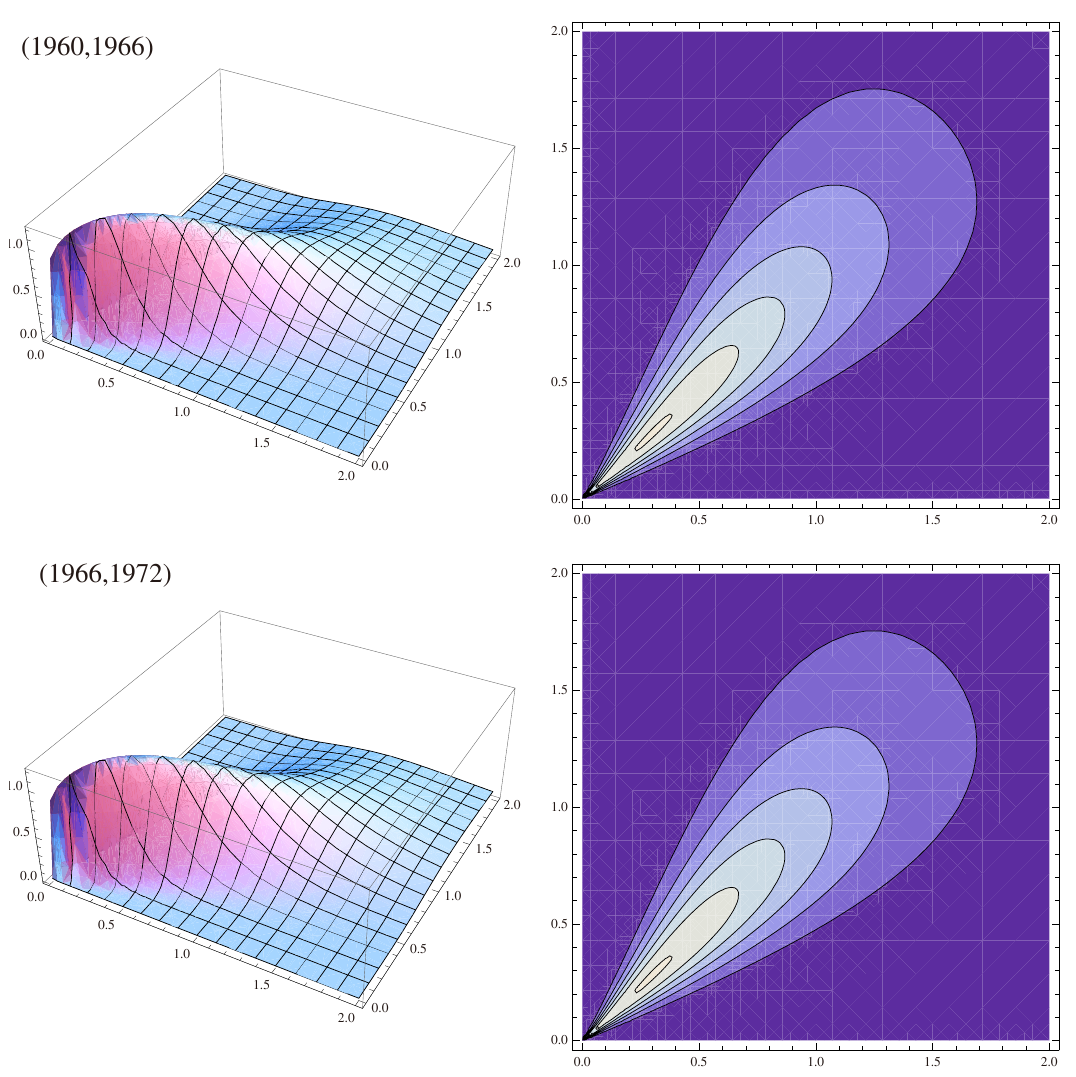
Figure 2. Joint pdf and contour plots of the bivariate income Singh–Maddala distribution for the years: ( 1960,1966 ) ( top ); and ( 1966,1972 ) ( bottom